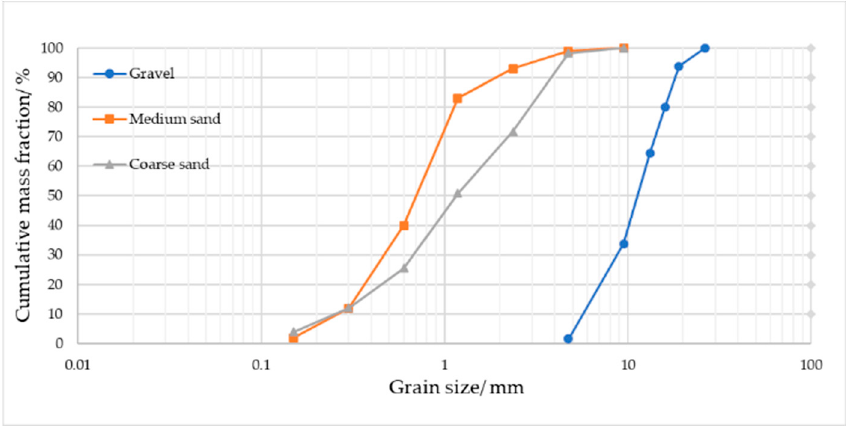
Figure 1. Particle size distribution curves for the sand and gravel aggregates. Table 1. Test Mix Proportion Scheme.